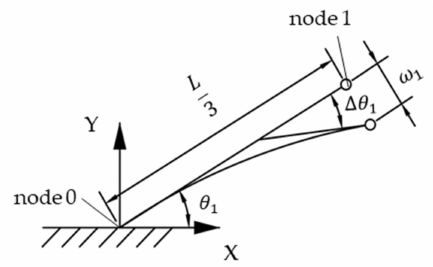
Figure A2. Deformation analysis of Unit